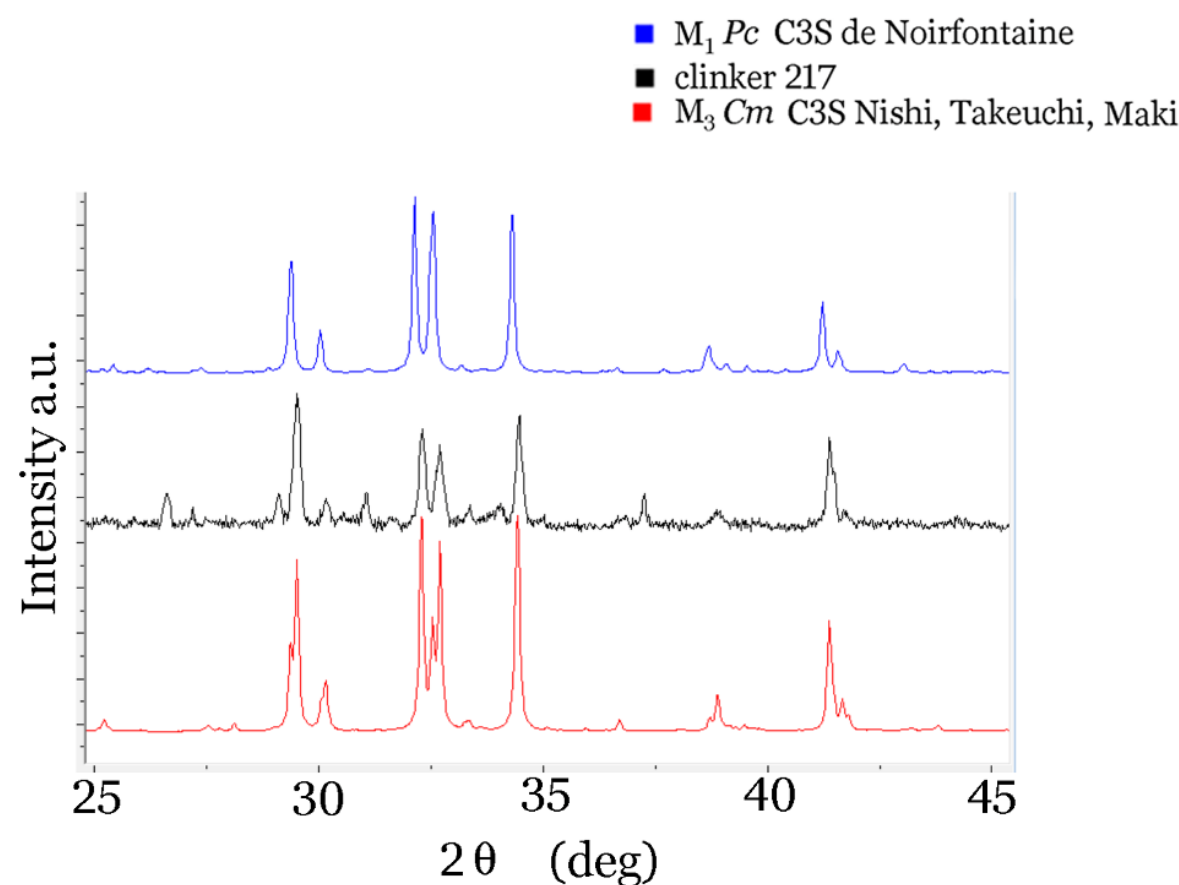
Figure 1. Comparison of the diffractogram of clinker 217 (middle) with the diffractogram of the phase M 1 Pc [50] (above) and with the M 3 Cm [69] (below) (interval 25°–45°).